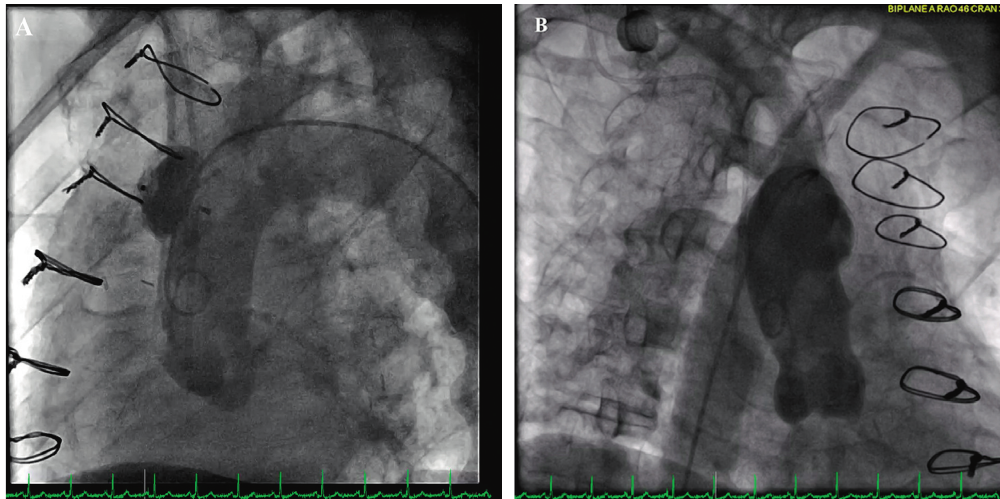
Figure 2: Invasive angiography with engagement of the ascending aortic arch, demonstrating a pseudoaneurysm in the anterior mid- ascending aorta. (a) LAO caudal view. (b) RAO cranial view.